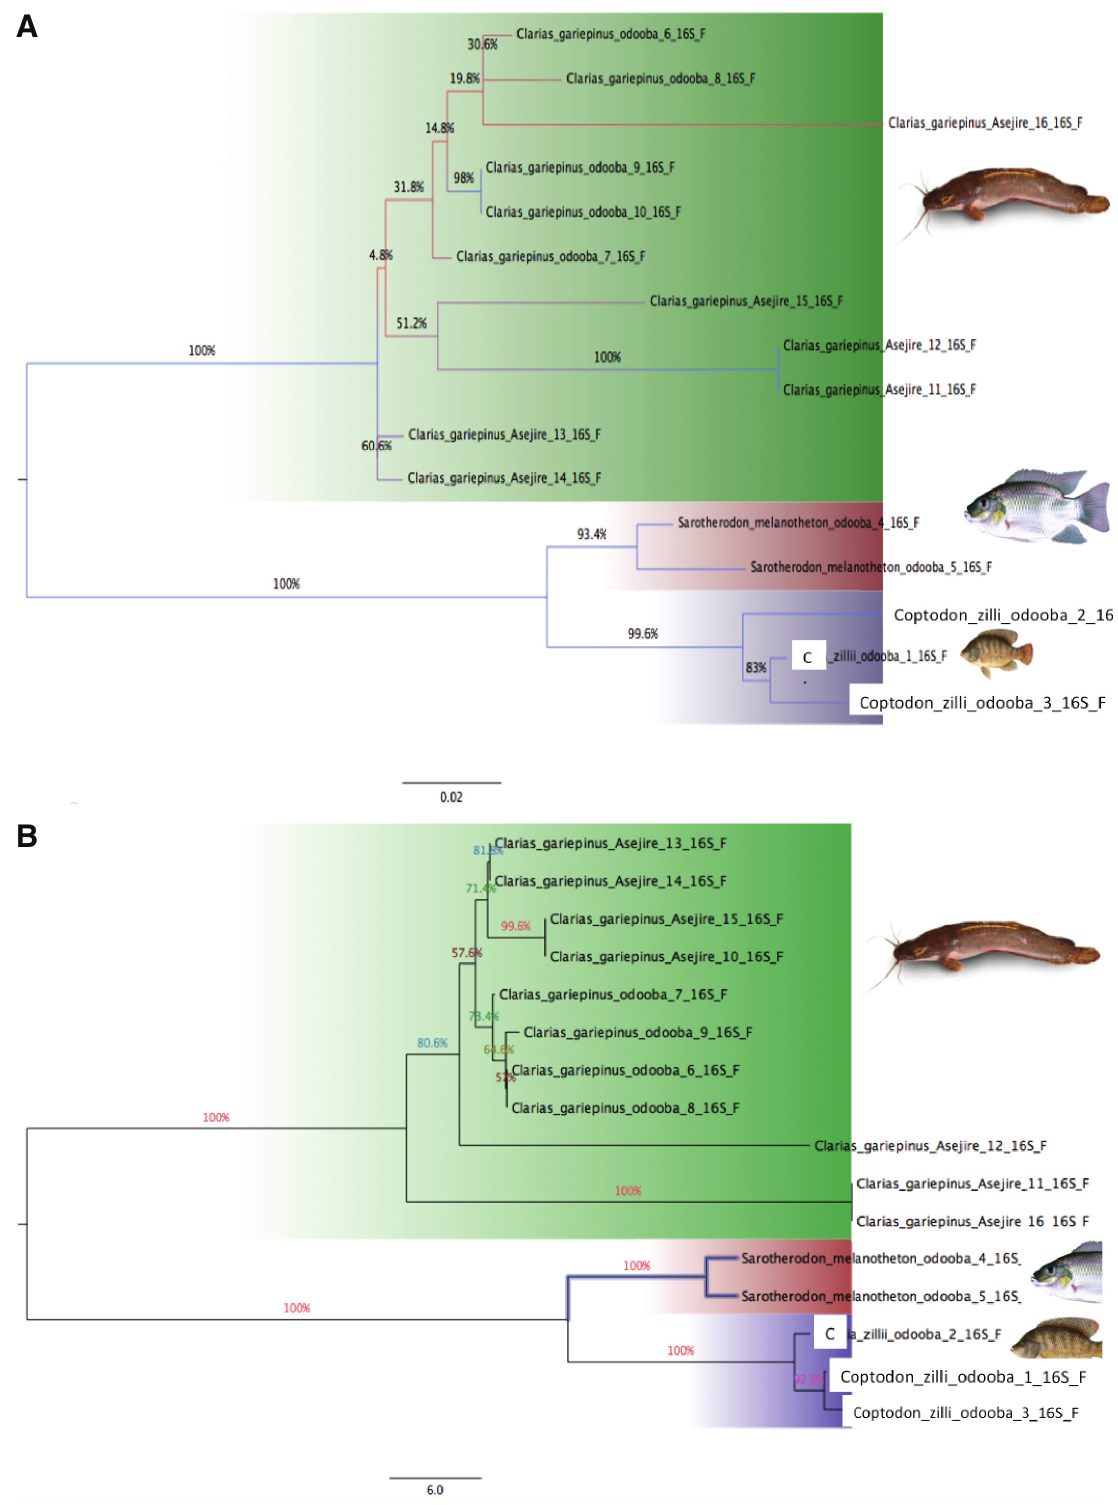
Figure 2. Phylogenetic analysis A . Maximum likelihood tree based on Tamura Neil 3P constructed for 16S rRNA gene sequences. B . Neighbour- joining trees based on number of difference model constructed from16S rRNA gene sequences. (Bootstrap test was 1000